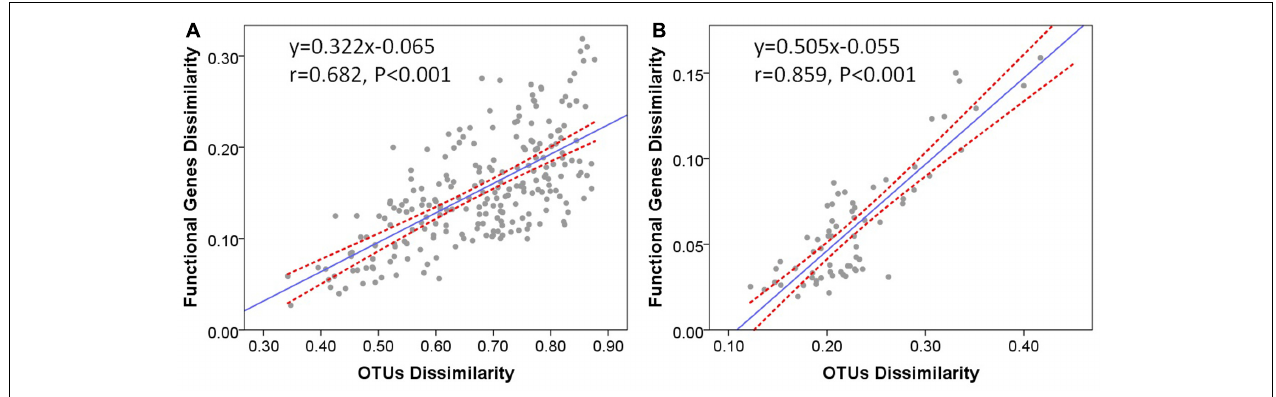
FIGURE 6 | Bray–Curtis dissimilarities of functional genes versus Bray–Curtis dissimilarities of OTUs in (A) stream biofilms and (B) Qinghai Lake water. One point represents one sample pair. The Pearson correlation coefficient (r) and statistical significance (P) of linear regression are shown. Dotted lines indicate 95% confidence intervals.